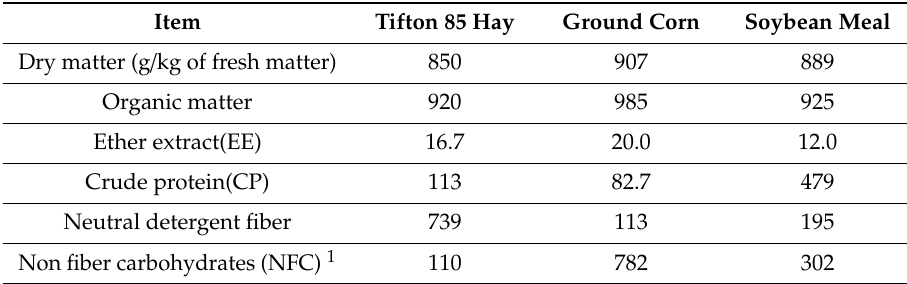
Table 1. Chemical composition (g / kg dry matter) of ingredients used.